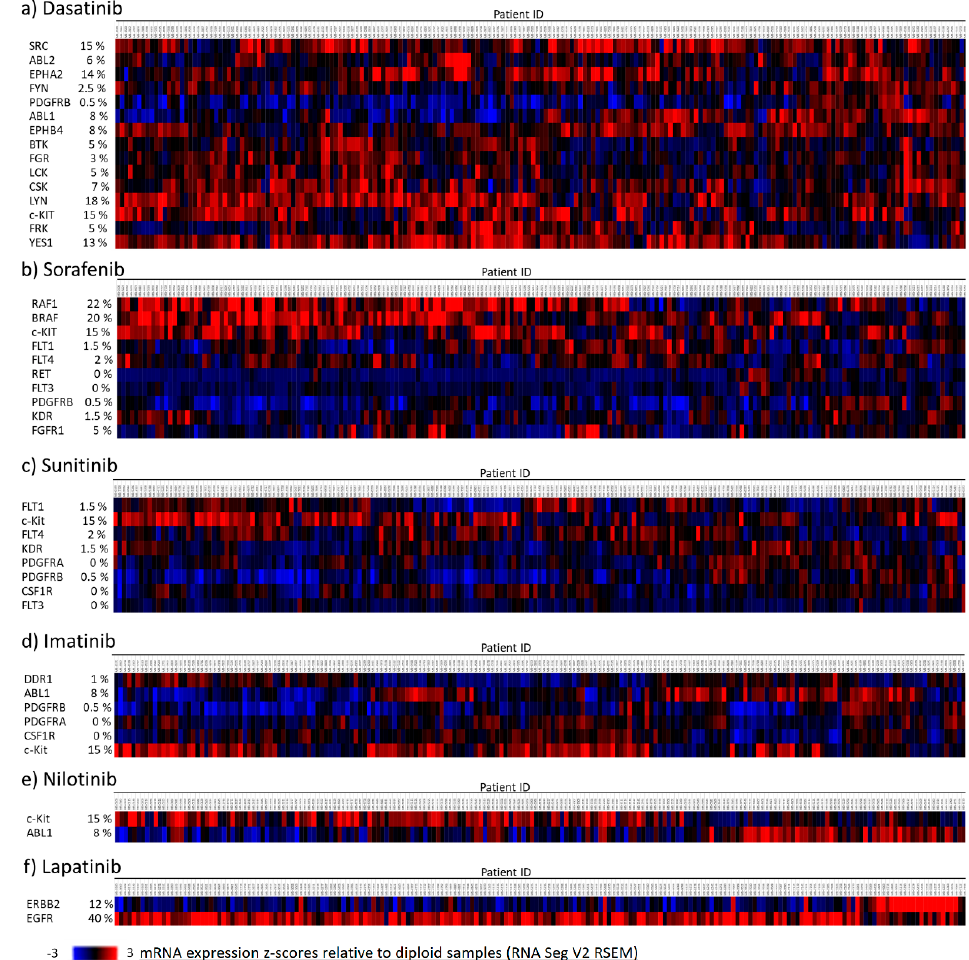
Figure 6. Expression of TKI-targeted RTKs and intracellular tyrosine kinases in TNBC tumor samples . The expression of the RTKs and intracellular tyrosine kinases that are targeted by ( a ) Dasatinib, ( b ) Sorafenib, ( c ) Sunitinib, ( d ) Imatinib, ( e ) Nilotinib, and ( f ) Lapatinib was investigated using the METABRIC transcriptomic datasets. A cohort of 199 patients was analyzed. Samples with a z-score relative to diploid samples >2 were considered to have overexpression of the specific target molecule. The percentage of patients showing overexpression of each tyrosine kinase is presented.